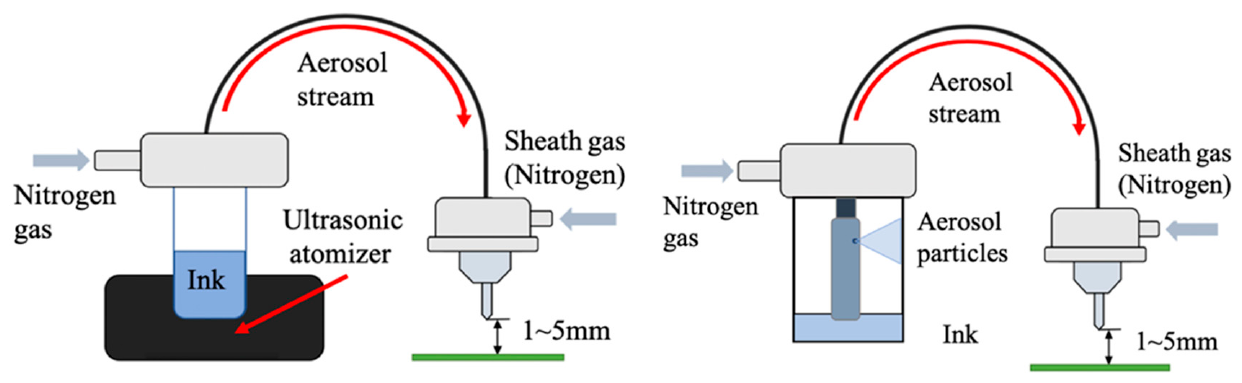
Figure 1. The aerosol jet printer modules. Ultrasonic atomizer ( left ) and pneumatic atomizer ( right ). For the detailed information of printing process, the width of printing the NiO track was 30 µ m, the printing speed was 2 mm/s, and the spacing of tracks was 20 µ m; therefore, the overlap of the tracks was 10 µ m, which produced even NiO thin films. In Table 1, the detailed information of the raw NiO thin films was exhibited. Table 1. Detailed information of non-sintered NiO nanoparticle thin films as fabricated by aerosol jet. Average Thickness of Height of Raw NiO Thin Films Resistance at 100 ◦ C Average of Roughness NiO Thin Films Satellite Particles 15 µ